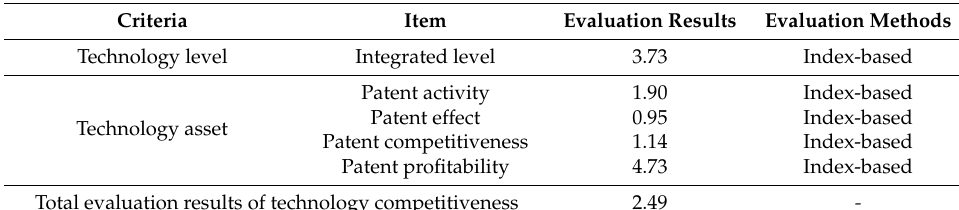
Table 11. Results of analysis on technological competitiveness—Department B.